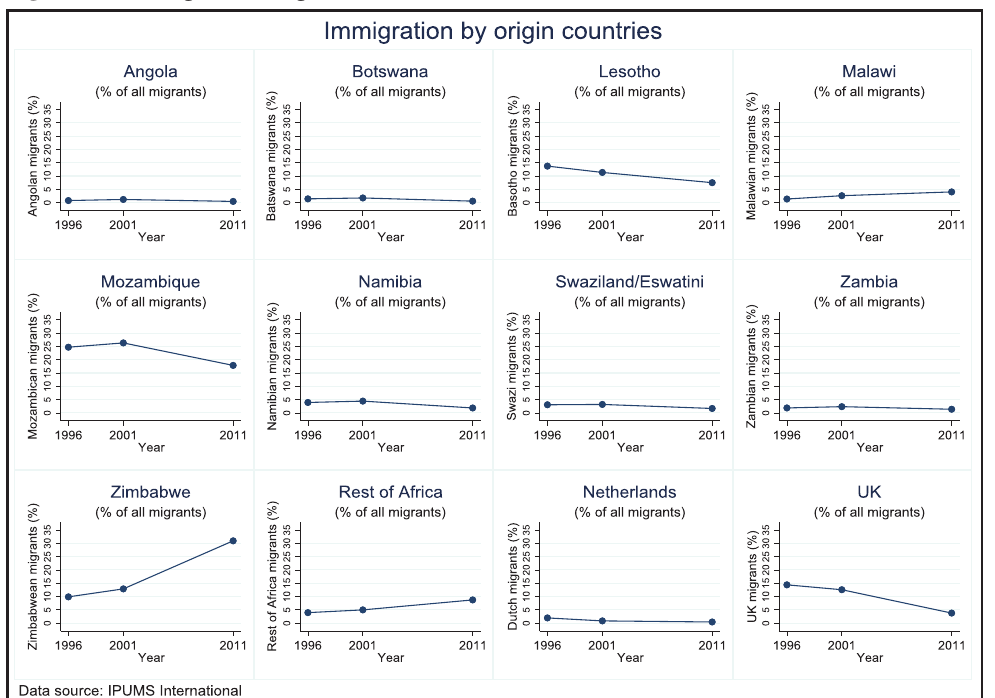
Figure 2 Immigrants’ origin countries.